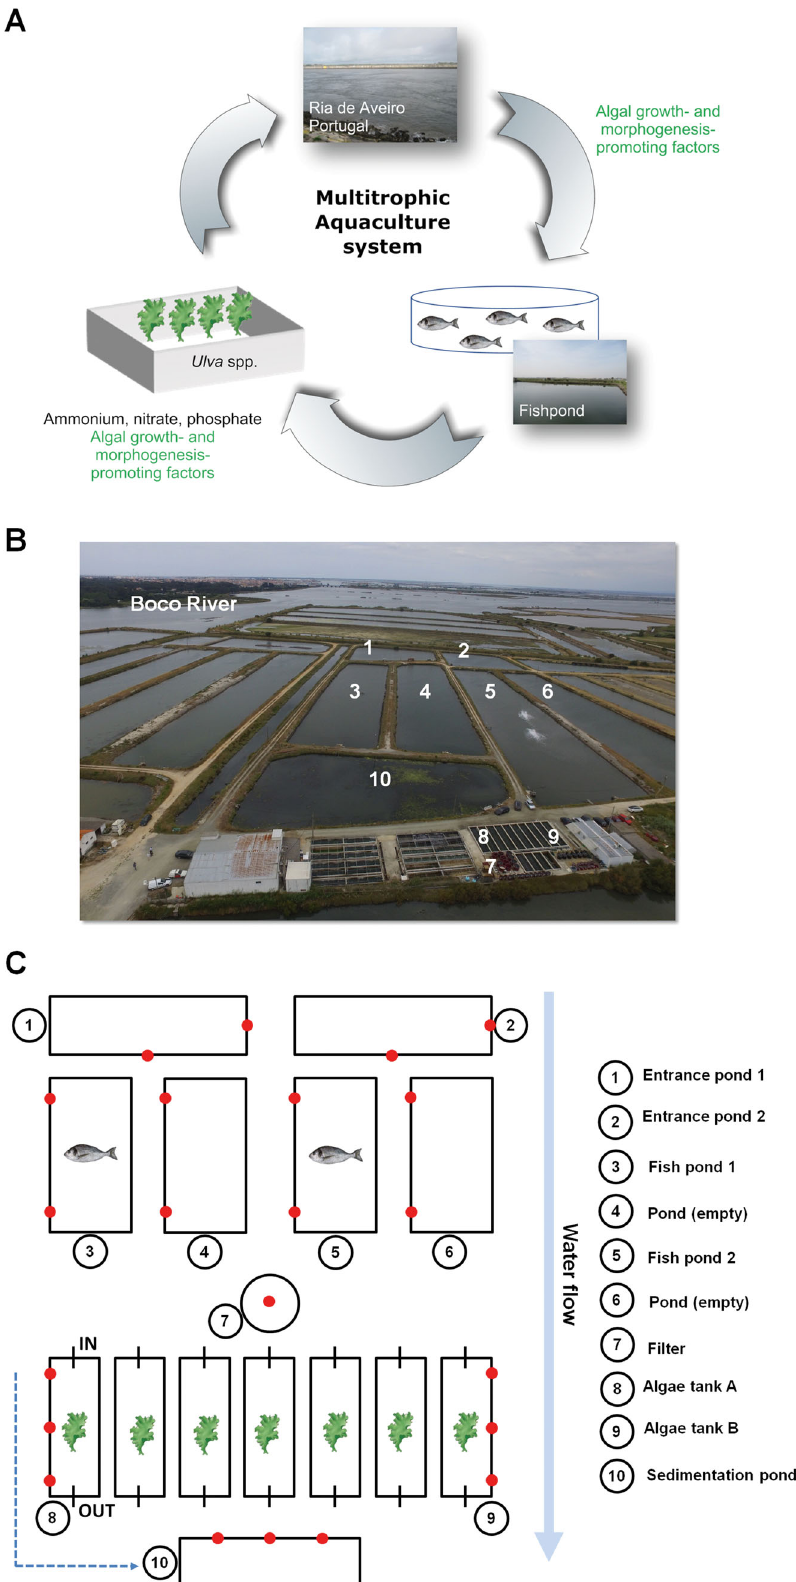
Fig. 1. (A) Working hypothesis: algal growth- and morphogenesis-promoting factors are present in the lagoon water and can contribute to sustain- able aquacultures. (B) Study site at the lagoon Ria de Aveiro. (C) Simplified scheme showing sampling points where water samples were col- lected at the multitrophic aquaculture system (red dots); water flows from entrance ponds through fish ponds to the algae tanks. Outflow from all production units (blue dashed line) is discharged to the sedimentation pond and thus mixed with the fish effluent before entering